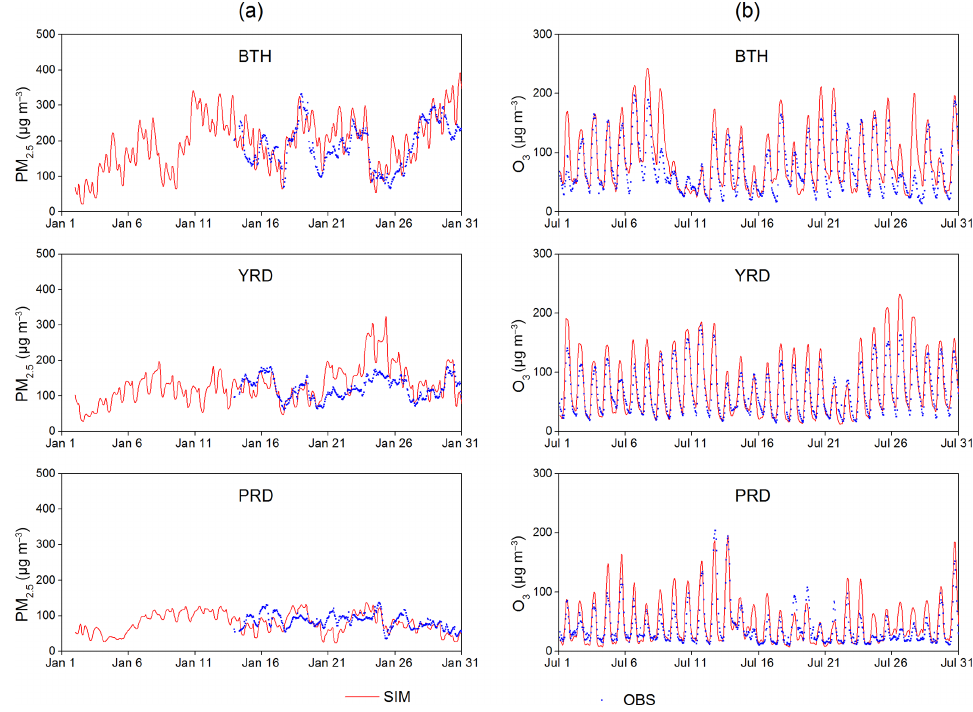
Figure 8. Time series of hourly concentrations of (a) PM 2 . 5 in January and (b) O 3 in July 2013, under the short-term air quality application over three key regions in China: the Beijing–Tianjin–Hebei area (BTH), the Yangtze River Delta (YRD), and the Pearl River Delta (PRD). The hourly concentrations in each region were derived by averaging all monitoring stations located in the